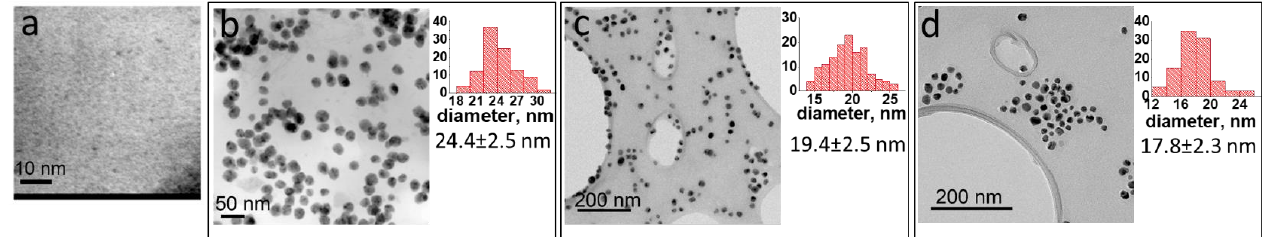
Figure 3. TEM images and size distributions of Ni NPs prepared by the injection approach at 220 °C ( a ), 240 °C ( b ), 260 °C ( c ) and 280 °C ( d ) within 30 min at Ni(acac) 2 /PPP = 0.5 mmol/0.148 g.